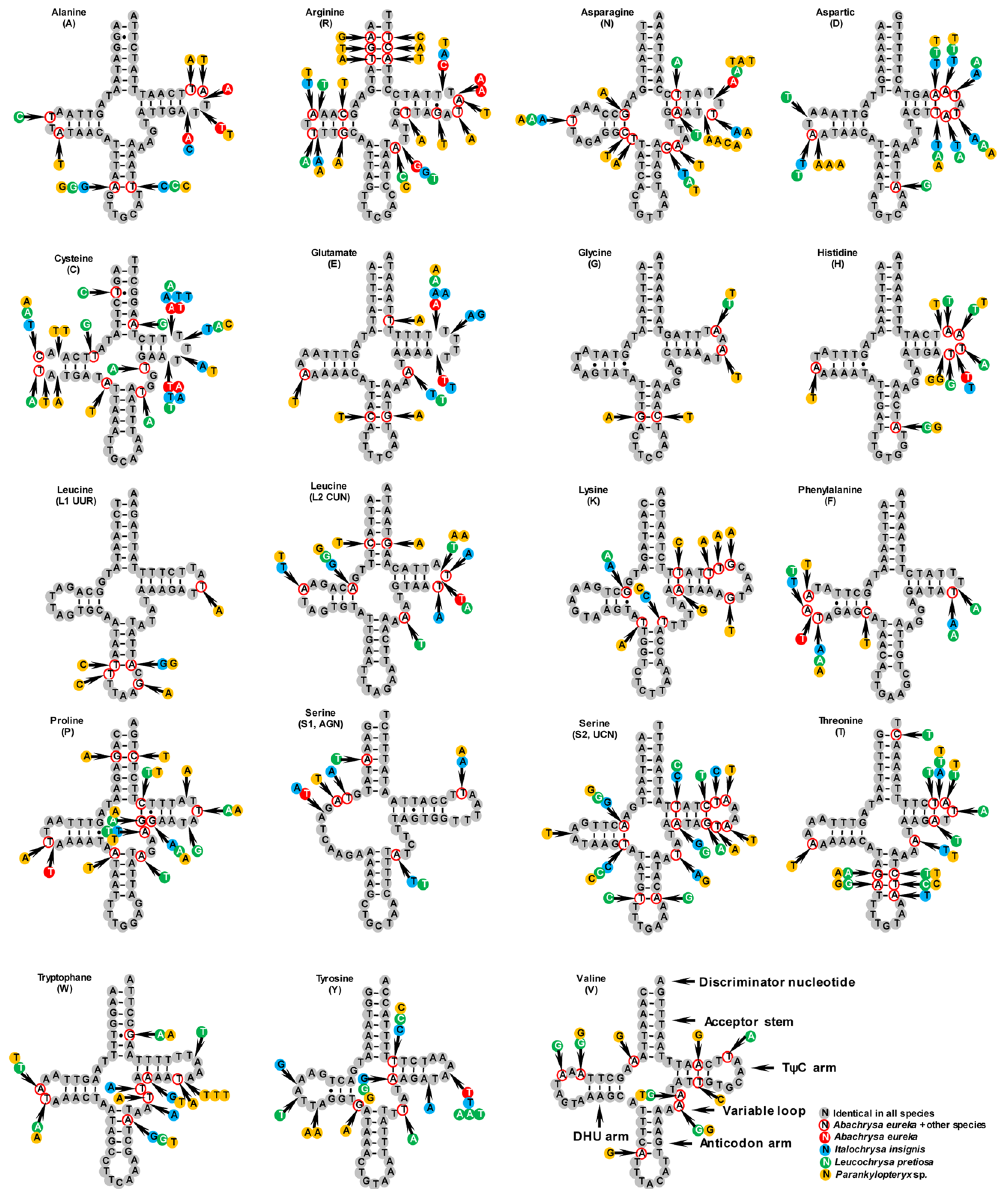
Figure 2. Inferred secondary structure of 19 tRNAs in the mt genome. Most tRNAs are labeled with the abbreviations of their corresponding amino acids. Dash (-) indicates Watson-Crick bonds and dot ( • ) indicates GU